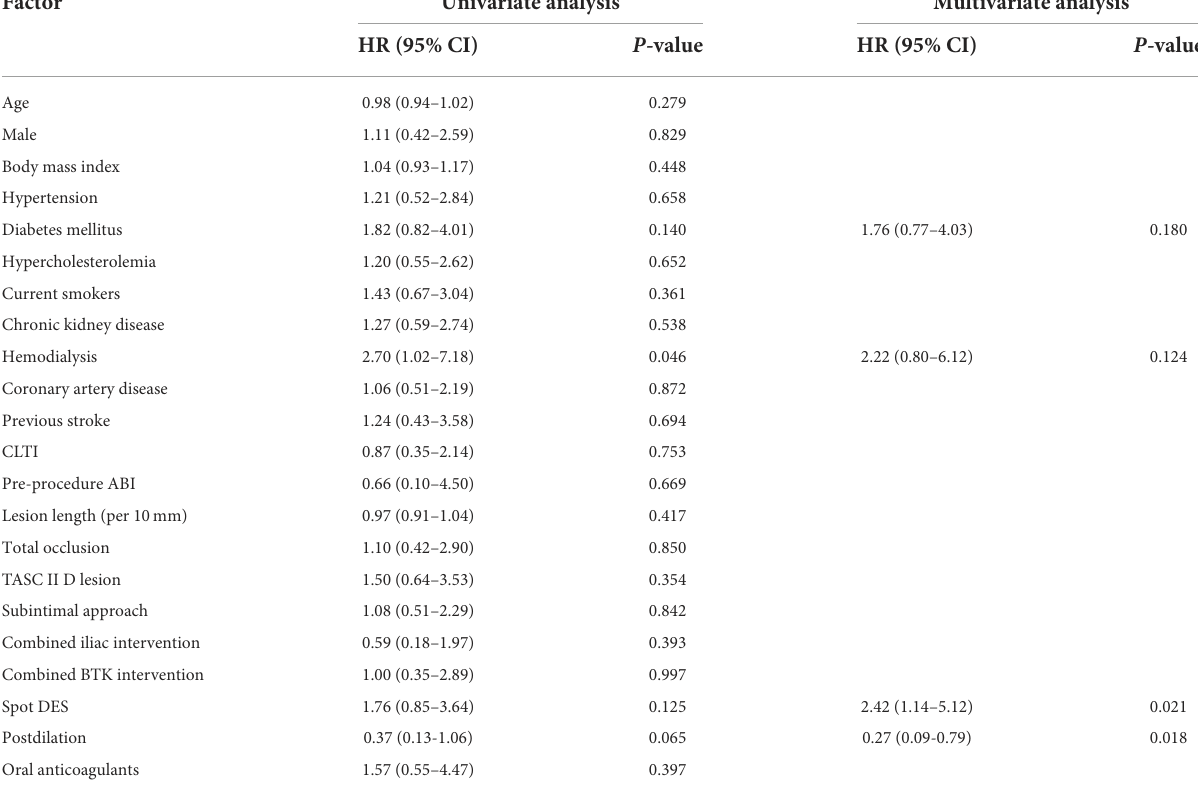
TABLE 3 Predictors of loss of patency at 12 months in Cox proportional hazards regression